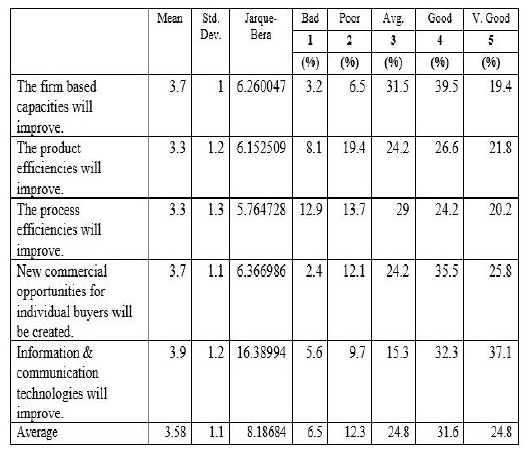
Table 1: Micro-Economic Aspects